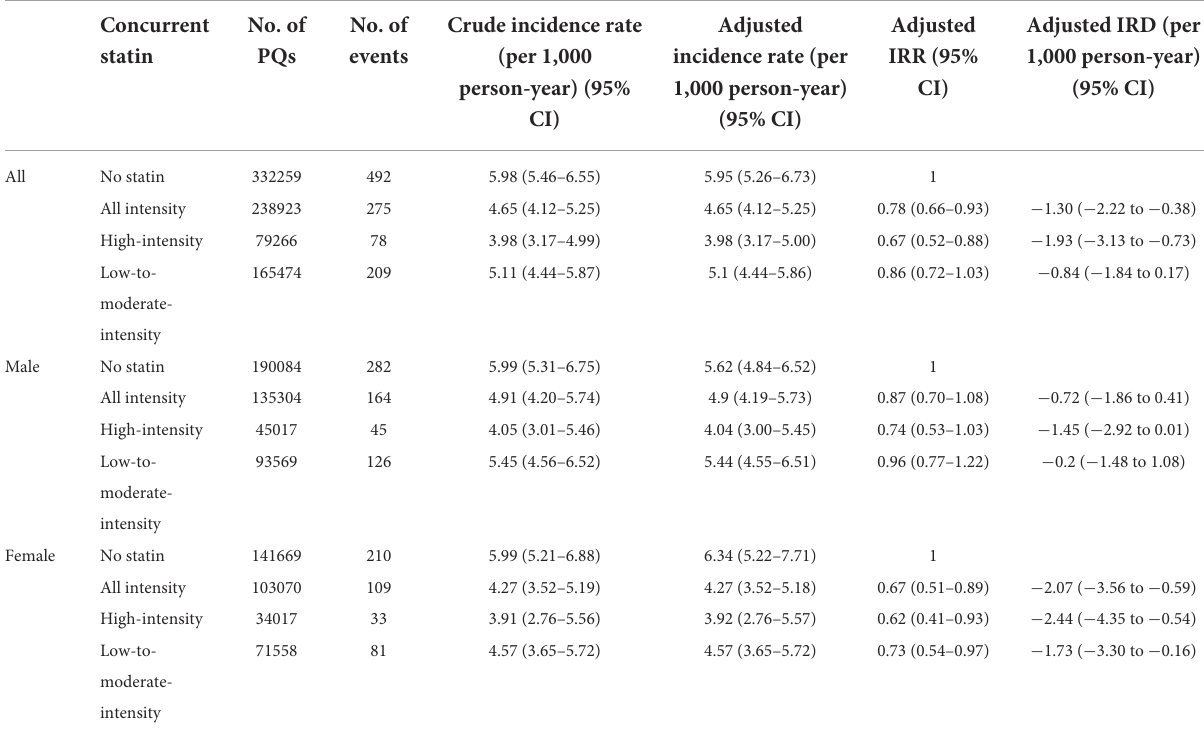
TABLE 3 Intracerebral hemorrhage among DOAC using patients. Intracerebral